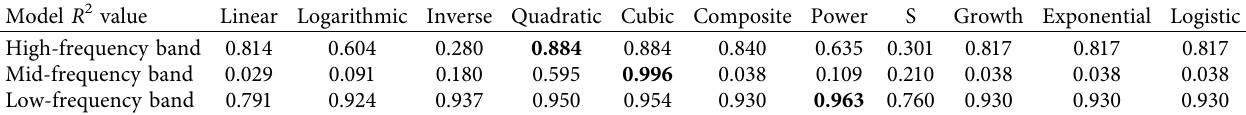
Table 2: The target spectral function expression form and R 2 value are determined when the proposed period point is equal to the calculated period